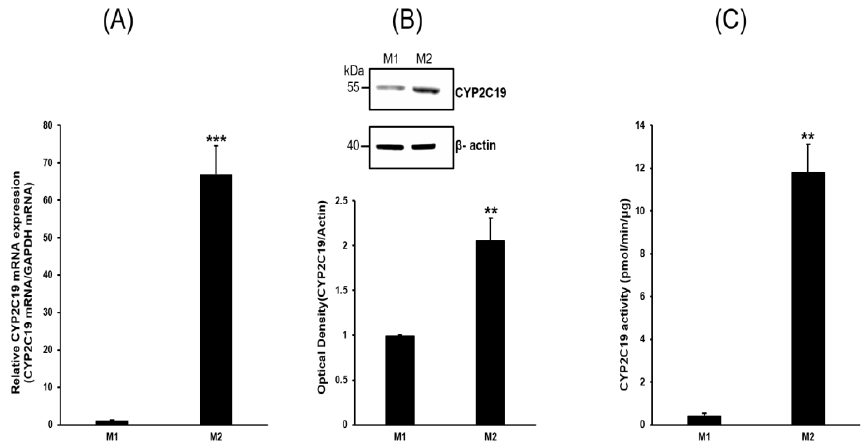
Figure 3. M2-macrophage-specific CYP2C19 expression. ( A ) Expression of CYP2C19 mRNA was determined using RT-qPCR. CYP2C19 mRNA was highly expressed in M2 compared to M1 macro- phages. ( B ) Western blot analysis of CYP2C19 and β-actin. CYP2C19 protein expression was high